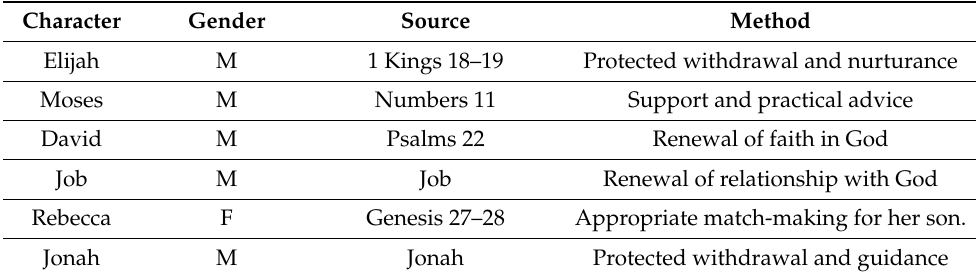
Table 3. Suicide Preventions in the Hebrew